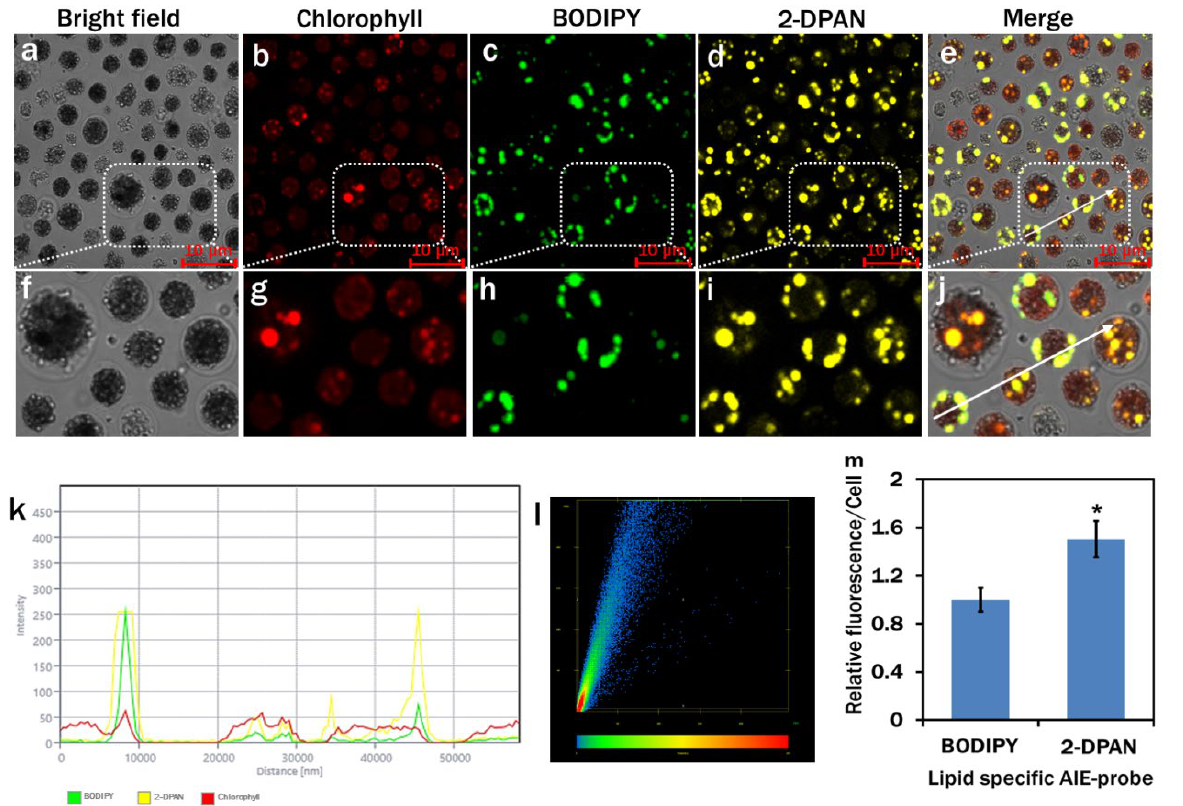
Figure 3. Confocal images of lipid drops in Chlamydomonas reinhardtii cells of Treatment 4 (MBL medium, ( − ) N 2 , (+) Sodium Acetate (2.0 g/L), ( − ) Ca 2+ , (24 h light condition)). Cells were labelled with traditional BODIPY™ 505/515 (5 µM; incubation- 5 min) ( c ) and AIE probe, 2-DPAN (20 µM; incubation-30 min) ( d ). (Bright-field images: ( a ); Fluorescence images—Chlorophyll: ( b ) (λ ex : 488 nm, λ em : 685–758 nm); BODIPY: ( c ) (λ ex : 488 nm, λ em : 490–517 nm); 2-DPAN: ( d ) (λ ex : 488 nm, λ em : 570–650 nm); Merged image: ( e – i ) and ( j ) are the enlarged regions of a–d respectively); ( k ) intensity profile of BODIPY and 2-DPAN in green and yellow channels, respectively; ( l ) intensity scatter plot for the colocalised channels; Pearson correlation coefficient and Mander’s overlap coefficient were calculated as 0.91 and 0.92, respectively; ( m ) Relative fluorescence intensity/cell for lipid-specific probes. Values are relative to the control BODIPY dye. Averages shown as mean ±SE; * p < 0.05. Images were taken with Zeiss LSM 880 Airyscan confocal microscope.